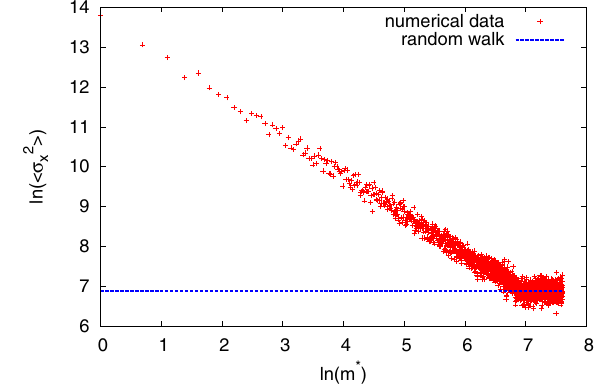
in y is changed y